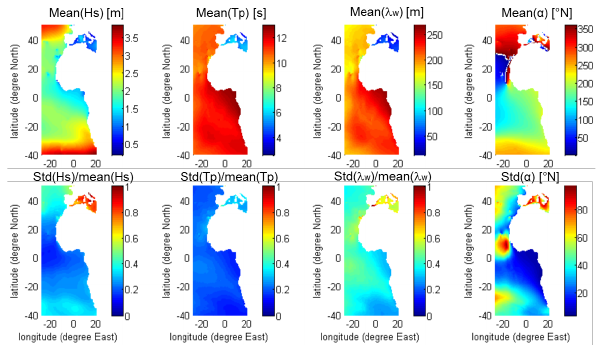
Fig. 3. 2012 Wave Climate. Yearly averaged values of: significant wave height H s (m), peak direction T p (s), wavelength λ w (m), wave Figure 3. 2012 Wave Climate. Yearly averaged values of: Significant wave height H s (m), 3 direction α ( ◦ , clockwise from North), together with the normalized peak direction T p (s), wavelength  w (m), wave direction α (°, clockwise from North), together 4 standard deviation. Source: IOWAGA wave hindcast database (Ras- with the normalized standard deviation. Source: IOWAGA wave hindcast database (Rascle 5 cle and Ardhuin, and Ardhuin, 2013). 6